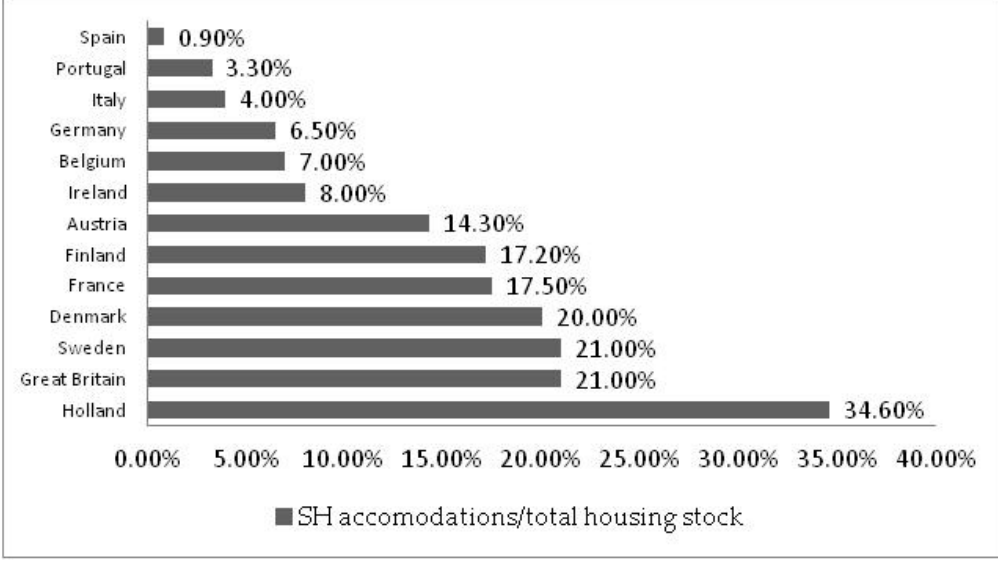
Figure 4. Stock of public housing wealth in the biggest European countries. Source: author’s elaboration on Censis data [51].